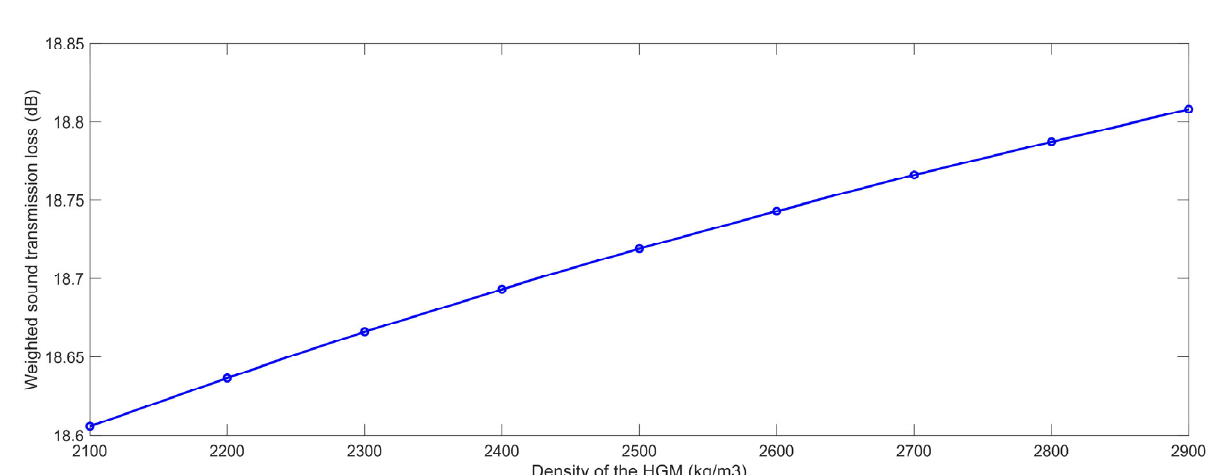
Figure 15. The weighted STL of composite rubber reinforced with HGM for the various density of the